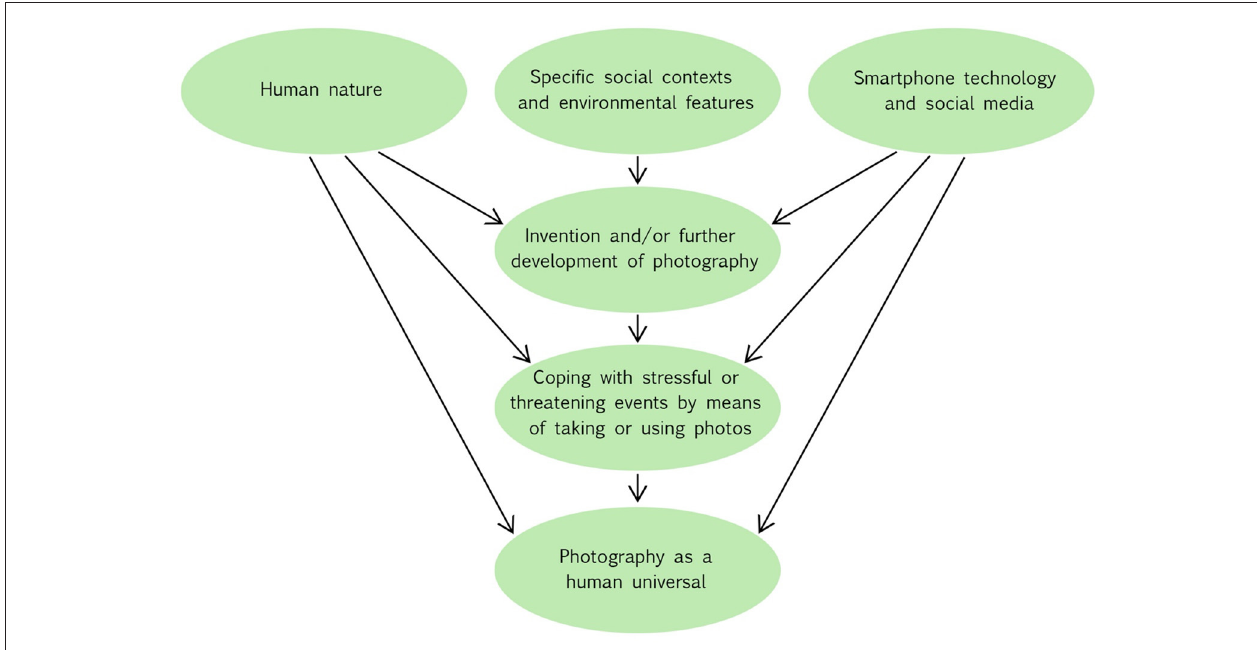
FIGURE 3 | The Mental Utilization Hypothesis of Photography. The schematic illustration shows the proposed conditions, components, and abilities that made photography a human universal. An arrow means “provides the basis for” or “leads